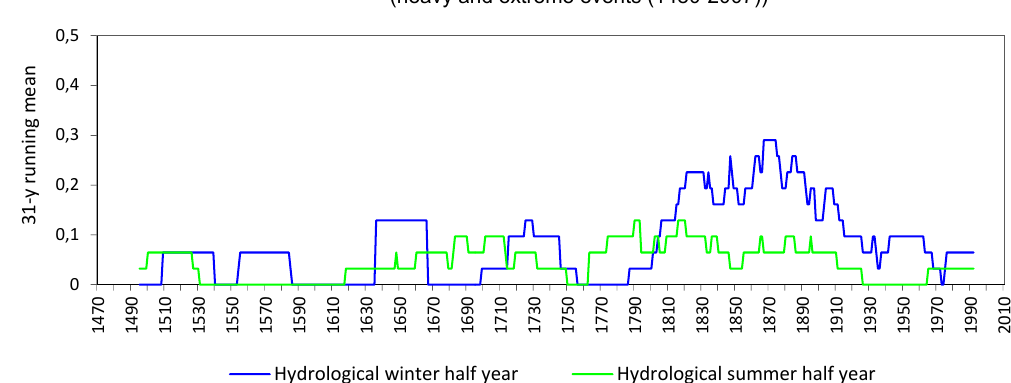
Figure 13. Floods of the River Kinzig (Baden-Württemberg) in the hydrological summer and winter years (big and extreme events).